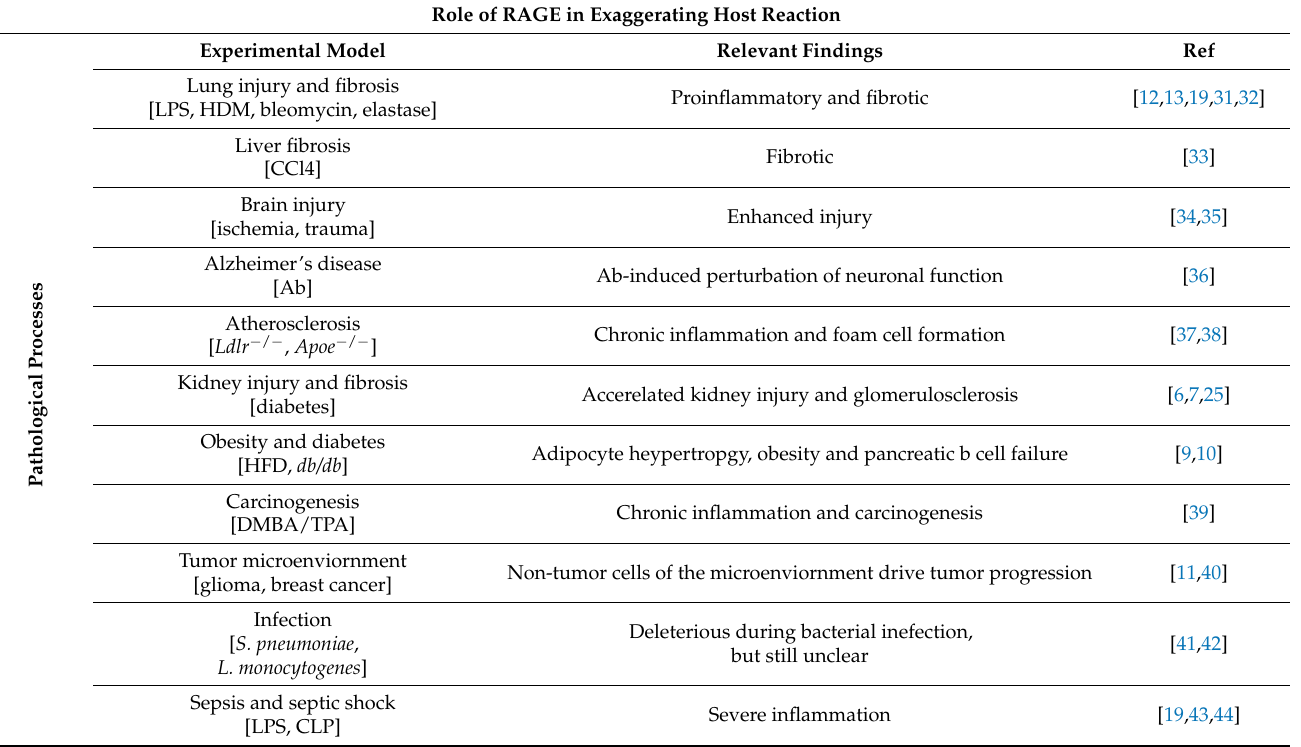
Table 1. Role of RAGE in physiological and pathological